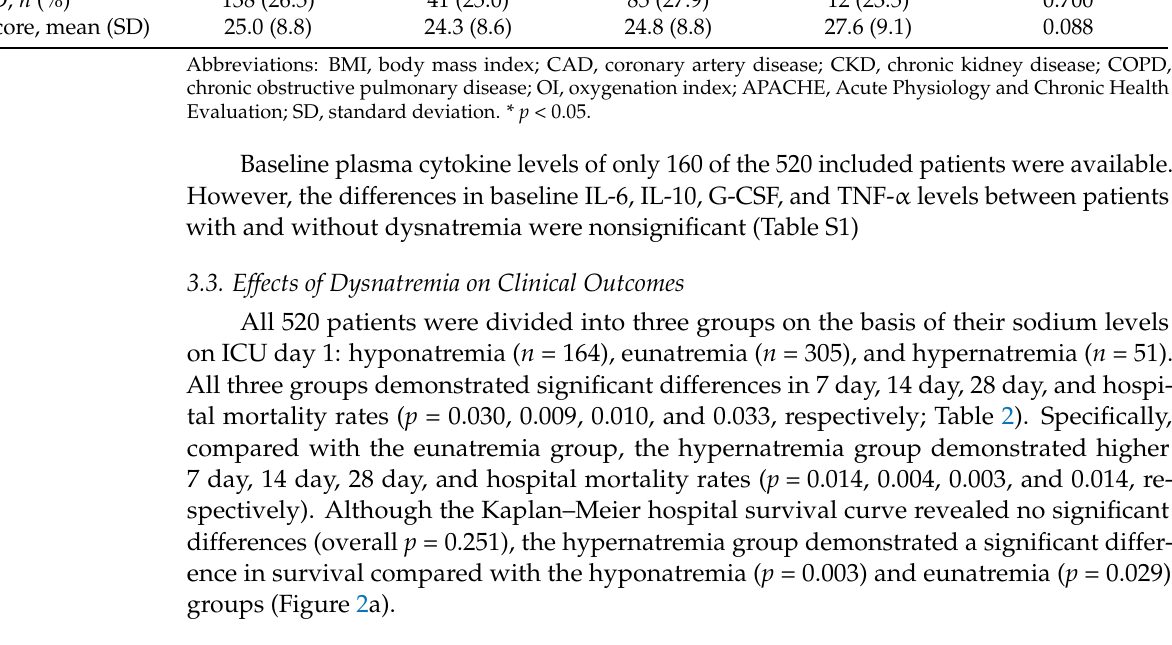
Table 2. Mortality outcomes of patients with